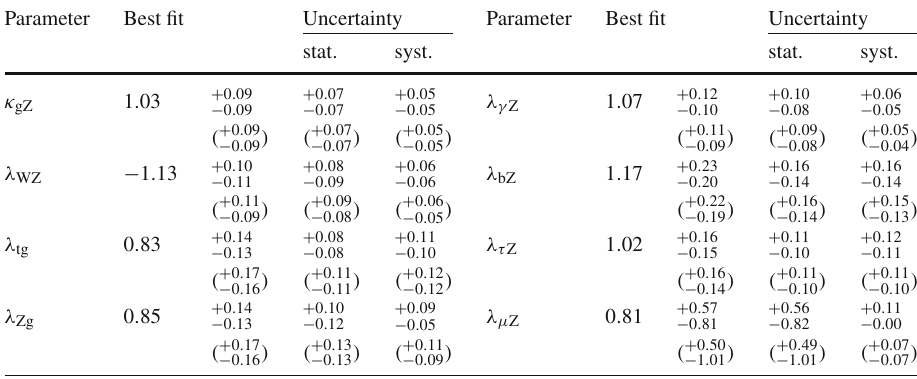
Table 9 Best fit values and Parameter Best fit Uncertainty Parameter Best fit Uncertainty ± 1 σ uncertainties for the stat. syst. stat. parameters of the coupling modifier ratio model. The expected uncertainties are given in brackets